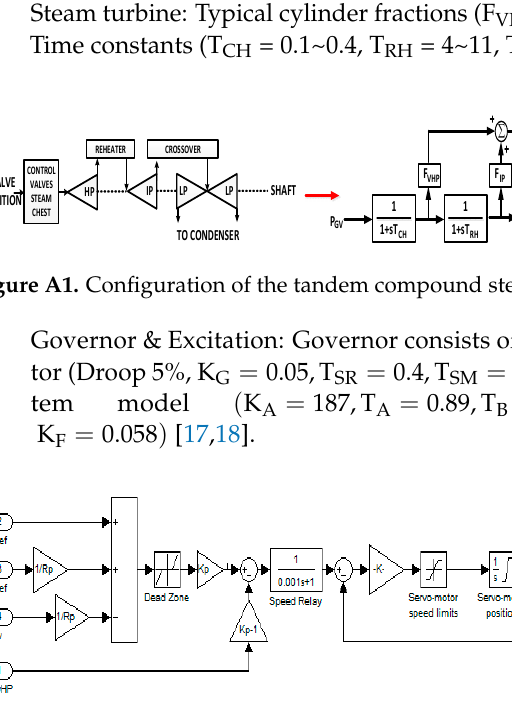
Figure A2. Configuration of the governor system.